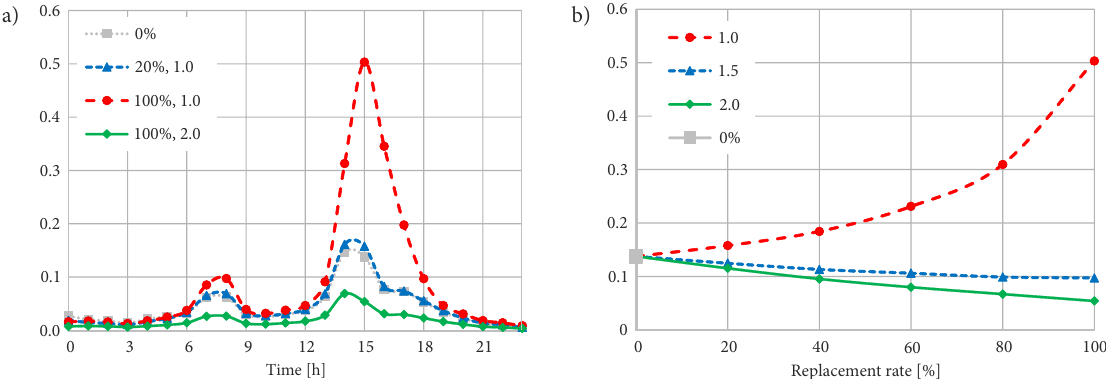
Figure 3. Travel delay ratios: a – hourly averages for selected simulation cases; b – peak-hour averages extrapolated to the 0% replacement case (grey